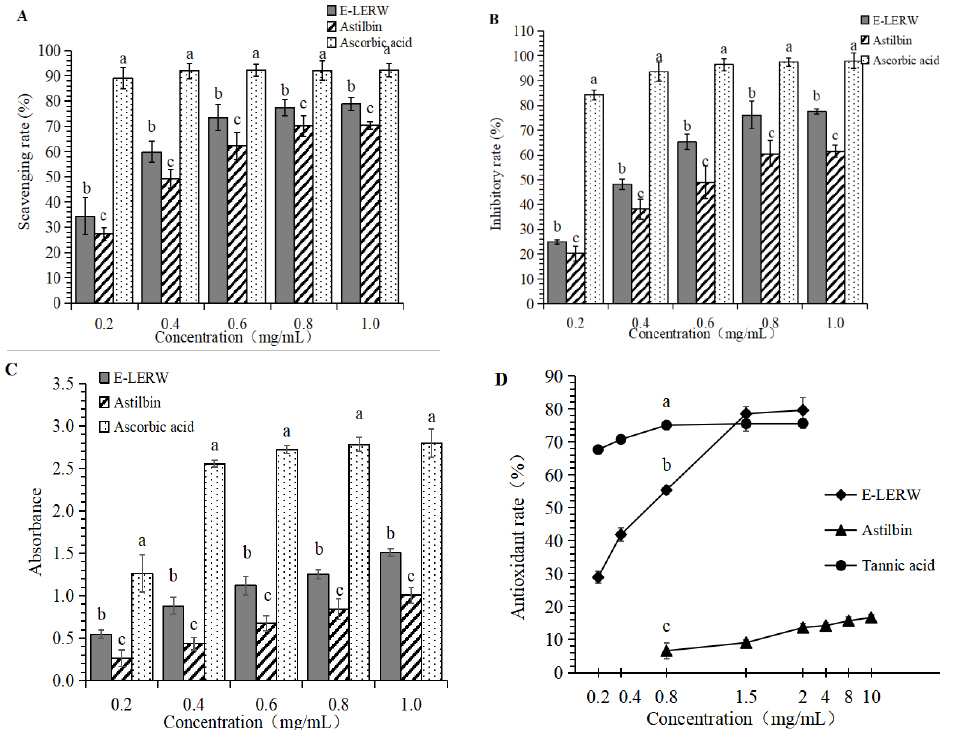
Figure 3. Antioxidant ability of E-LERW and astilbin: ( A ) Scavenging rate against DPPH radicals. ( B ) Scavenging rate against ABTS + radicals. ( C ) FRAP. ( D ) Inhibitory rate against lipid membrane oxidation. All values were expressed as the mean ± SD from triplicate experiments. The different letters represent significant difference at p < 0.05 by ANOVA and Duncan’s test. FRAP: Ferric reducing antioxidant power. Other abbreviations are as in Figure 1.